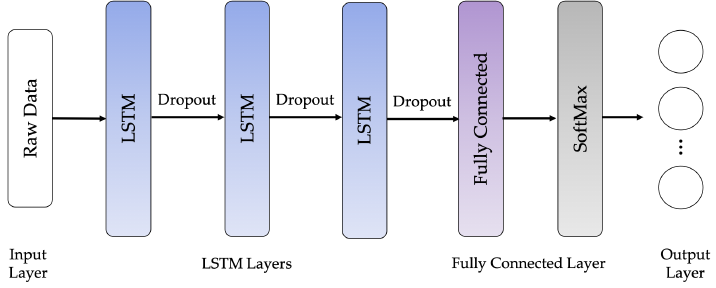
Figure 12. 3-Stacked LSTM network